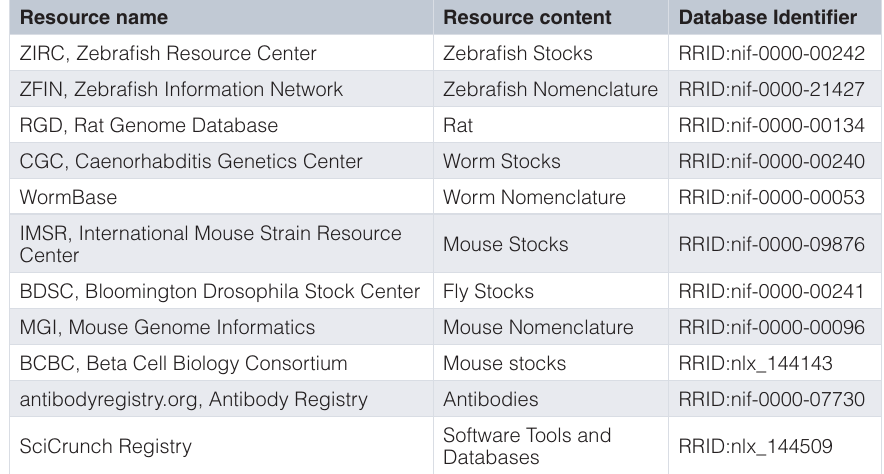
Table 1. Source databases and registries included in the RII portal. Each database has a weekly or monthly scheduled frequency of update and all new data is released weekly. If available, data from both model organism authorities is served as well as the list of strains available via particular stock centers. In most cases the stock centers maintain a link between the genotype and the stock center animal identifier. Scheduling and total data count information can be accessed via DISCO